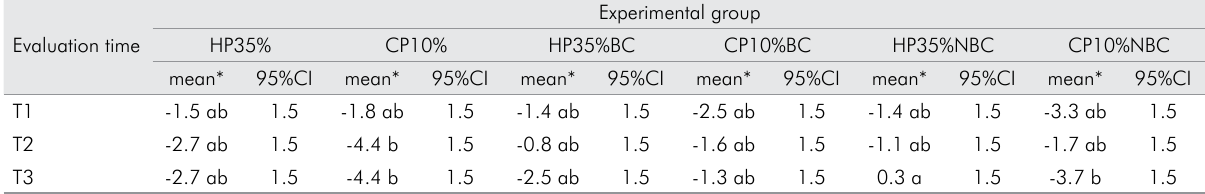
Table 3. Mean and Confidence intervals (95%CI) of luminosity (∆L) for each group during all evaluation times. Evaluation